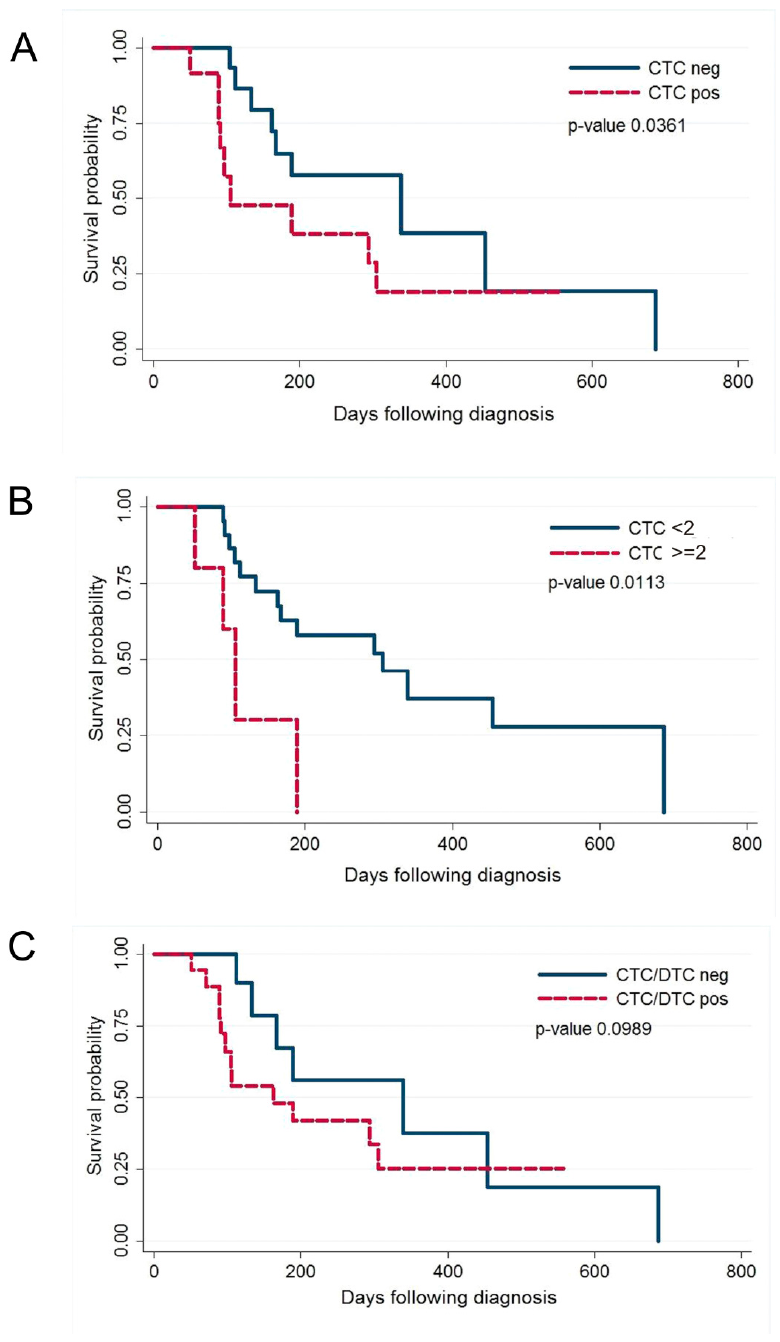
Figure 2. Kaplan–Meier (KM) estimates of probabilities of Survival Time (ST) in dogs with MMC. ( A ) KM for dogs with <1 CTCs per 7.5 mL of PB and those in the group with ≥ 1 CTCs per 7.5 mL of PB before initiation of therapy; ( B ) KM for dogs with <2 CTCs per 7.5 mL of PB and those in the group with ≥ 2 CTCs per 7.5 mL of PB before initiation of therapy; ( C ) KM for dogs with <1 CTCs and DTCs and those in the group with at least ≥ 1 CTCs or DTCs before initiation of therapy.